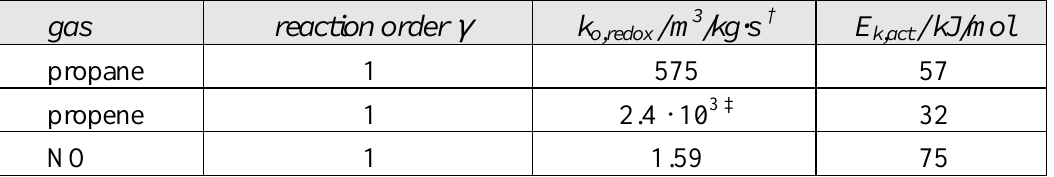
Table 2. Reaction constants for analyte oxidation over microscaled SrTi powders determined by additional catalytic tests (obtained from